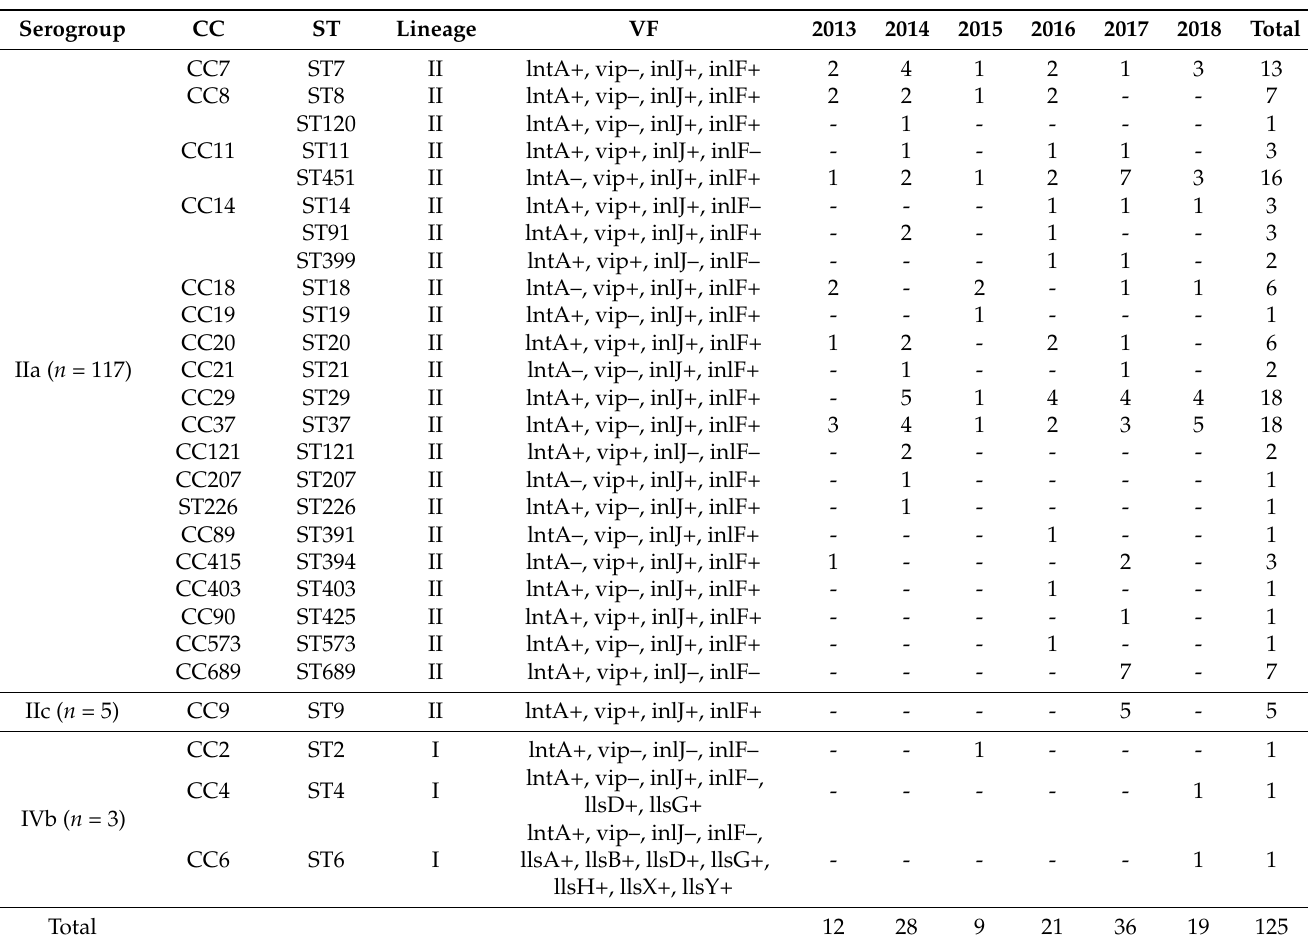
Table 1. L. monocytogenes isolates obtained from cattle abortion cases classified by the serogroup, clonal complex (CC), sequence type (ST), lineage and distribution of virulence factors (VF), n = 125, in Latvia,